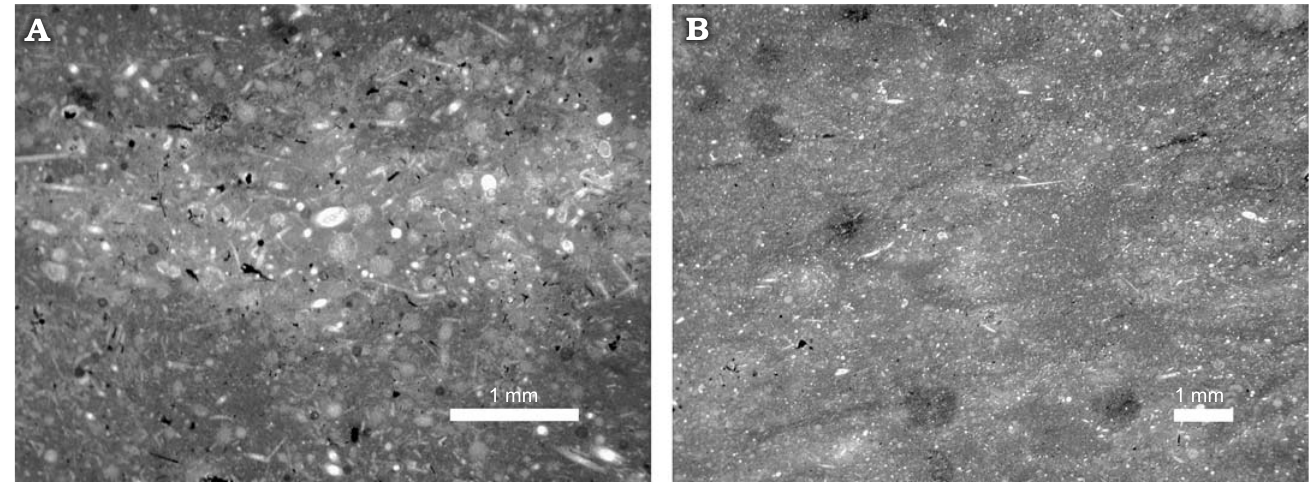
Fig. 5. Microfacies of grey marly limestone with high abundance of radiolarians and sponge spicules in micritic matrix. Bioturbation is indicated by brighter and darker areas. A . Sample Rö416. B . Sample Rö417.